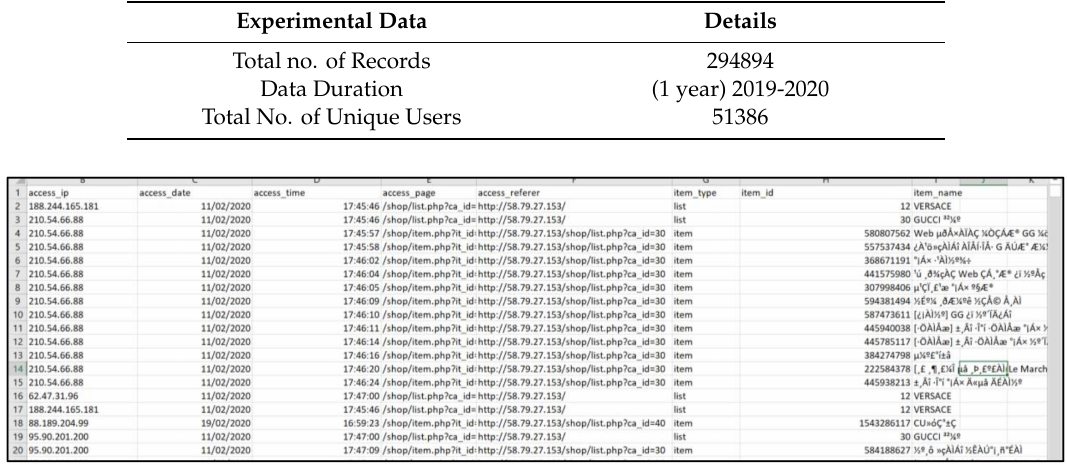
Figure 6. Sample of a log file.